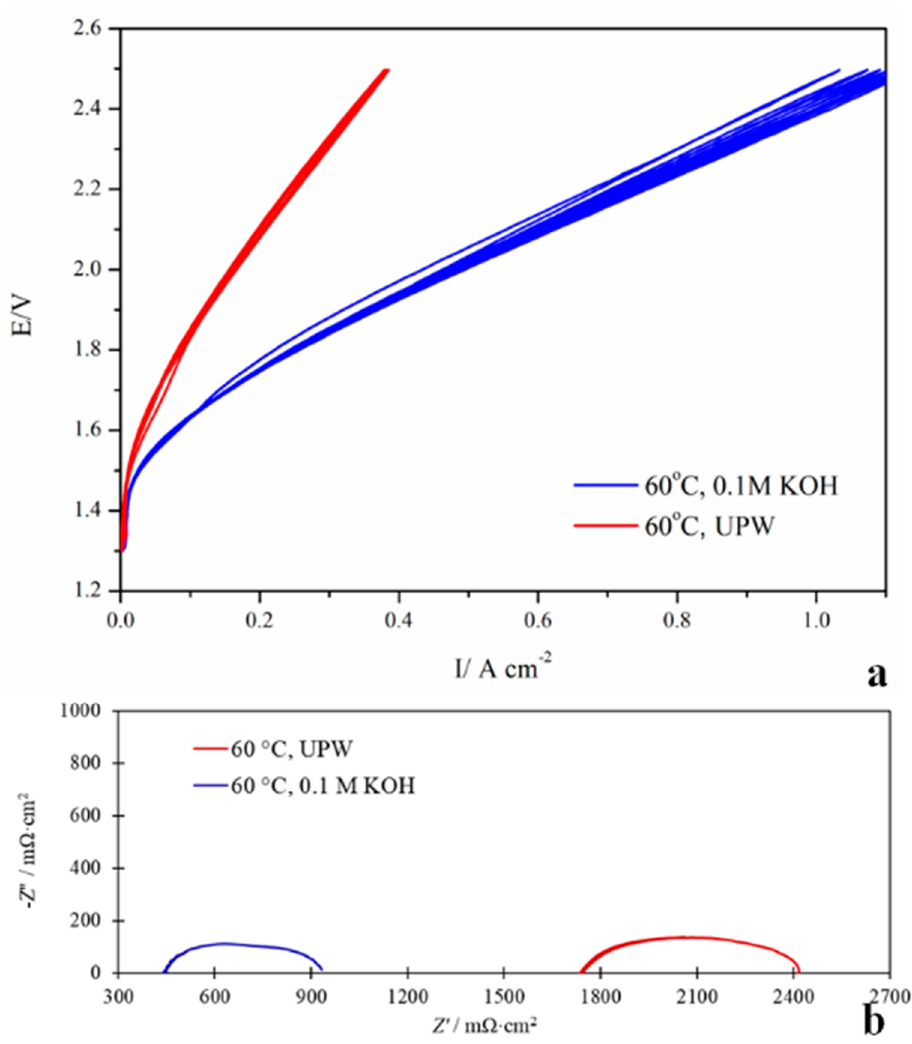
Figure 6. ( a ) AEM water electrolysis test IV curve results and ( b ) EIS recorded at 200 mA cm − 2 meas- at 60 ◦ C in ultra-pure water (UPW) and 0.1 M ured at 60 °C in ultra-pure water (UPW) and 0.1 M KOH.